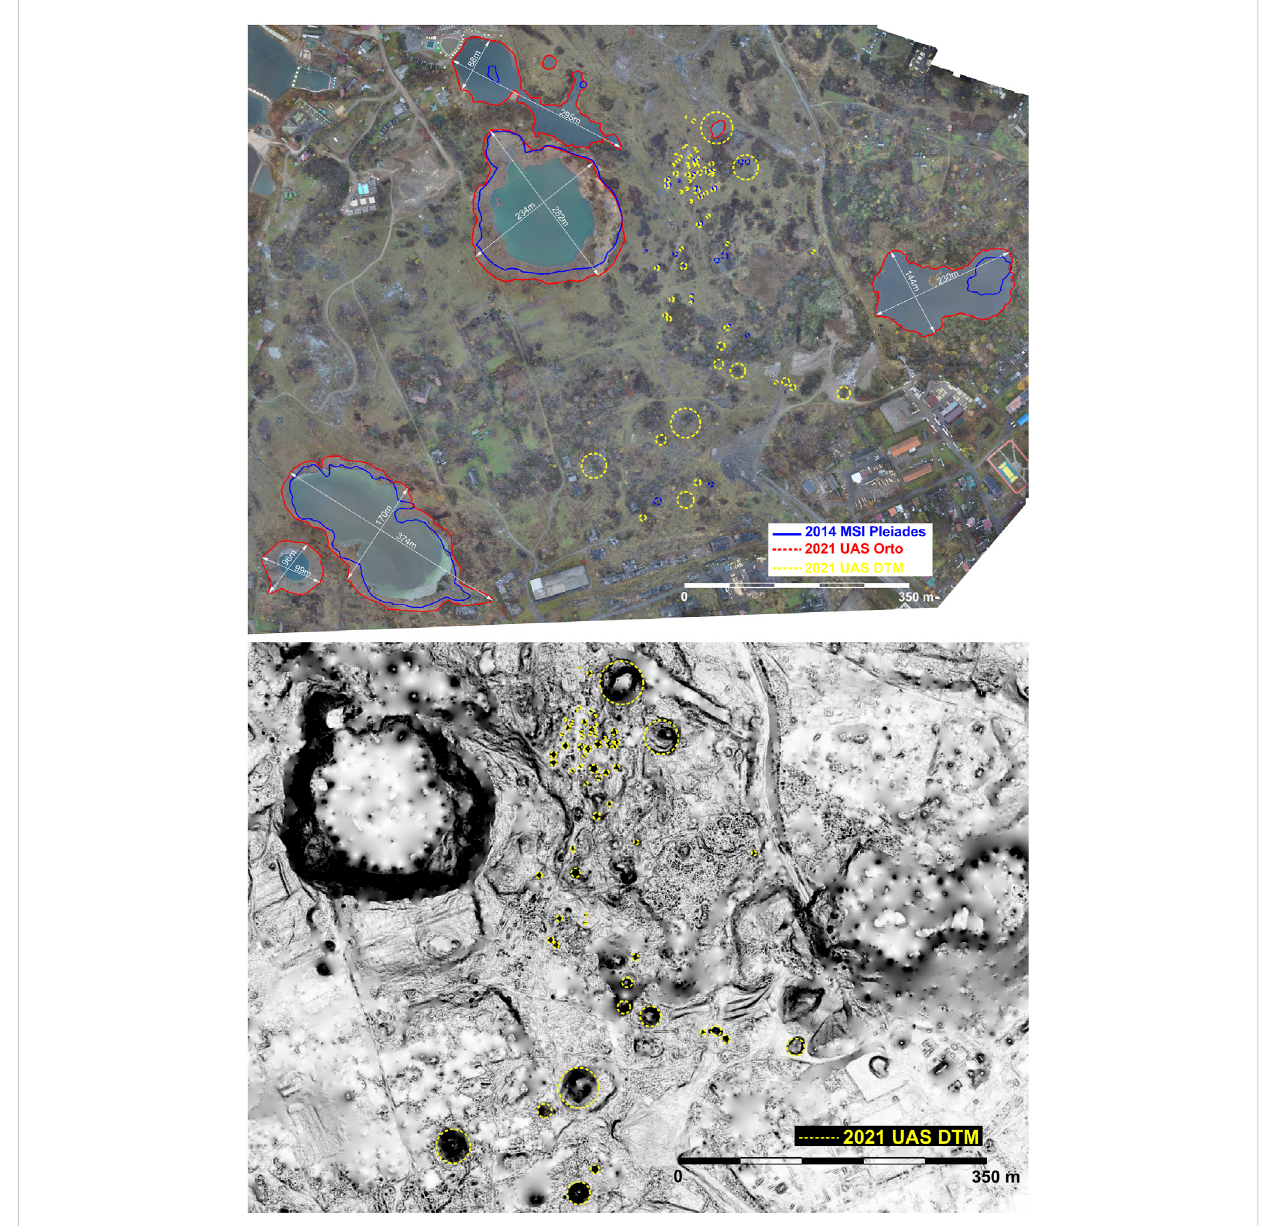
FIGURE 9 Extent ofmonitored areas in2014 and 2021basedon 2021 UAS orthophotomosaic(top);and newly emerging sinkholesdetected on DTM (bottom).